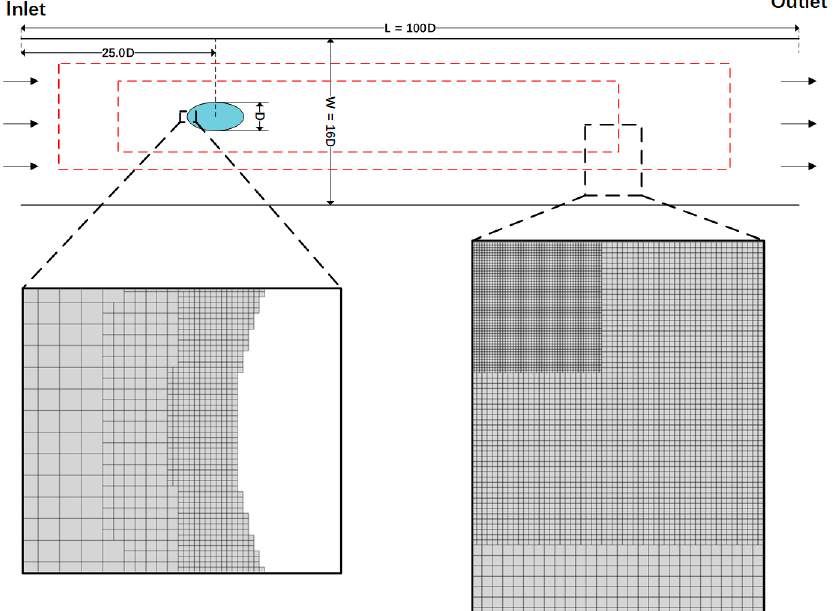
Figure 14. Diagram of the flow through the elliptical cylinder restrained in the channel. The red dashed lines indicate two regions of local mesh thinning within the enclosing box. The enlarged view on the right shows the localized detail at different resolutions in the three enclosing boxes. The enlarged view on the left shows the details of the local mesh refinement of the fitting mesh at the boundary of the elliptical cross section.